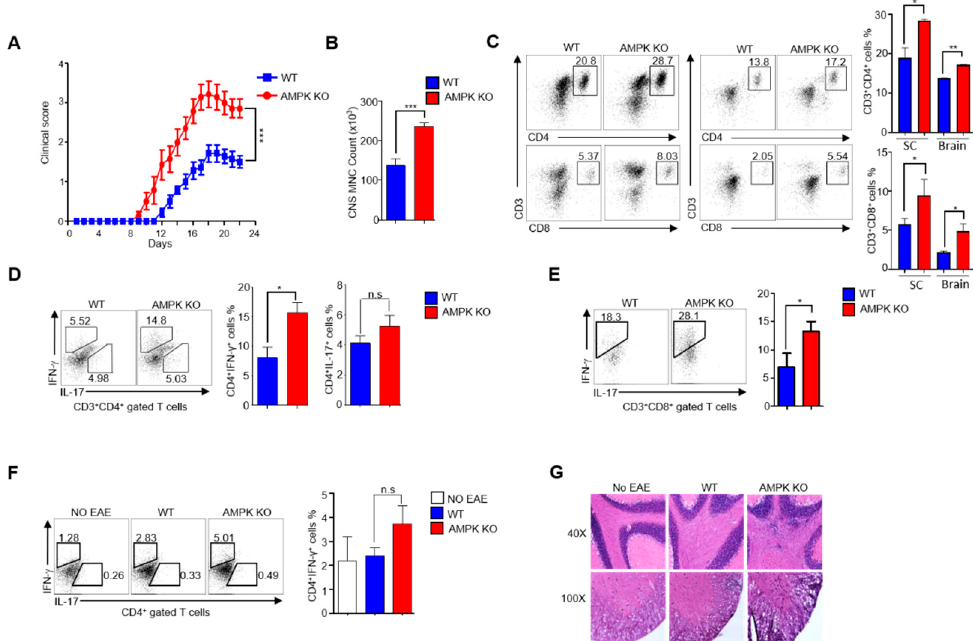
Figure 3. AMP-activated protein kinase (AMPK) loss abolishes the ability of regulatory T cells (Tregs) to resolve experimental autoimmune encephalomyelitis (EAE) in aged mice. Active EAE was induced in 24–30-week-old C57BL/6J mice. ( A ) Measurement of disease severity in terms of clinical score based on the signs and symptoms after inducing EAE in Foxp3 ypf-cre (WT) and AMPK α 1 fl/fl Foxp3 yfp-cre (AMPK-KO) mice ( n = 5 mice per group) ( B ) Total mononuclear cell count from EAE-induced WT and AMPK-KO mice spinal cord. ( C ) Flow cytometric analysis of the percentage of CD3 + CD4 + and CD3 + CD8 + T cells from (left) spinal cord and (right) brain of EAE-induced WT and AMPK-KO mice. ( D ) Flow cytometric analysis of the percentage of IFN- γ and IL-17A in CD3 + CD4 + gated T cells from spinal cord of EAE-induced WT and AMPK-KO mice. ( E ) Flow cytometric analysis of the percentage of IFN- γ in CD3 + CD8 + gated T cells from spinal cord of EAE-induced WT and AMPK-KO mice. ( F ) Flow cytometric analysis of the percentage of IFN- γ and IL-17A in CD3 + CD4 + gated T cells from the spleen of EAE-uninduced WT, EAE-induced WT, and EAE-induced AMPK-KO mice ( G ) Photomicrograph of brain sections of EAE-uninduced WT, EAE-induced WT, and EAE-induced AMPK-KO mice stained with hematoxylin and eosin (H&E) staining 22 days post EAE induction. * p < 0.05, ** p < 0.01, *** p < 0.001 and n.s means non-significant ( p > 0.05).